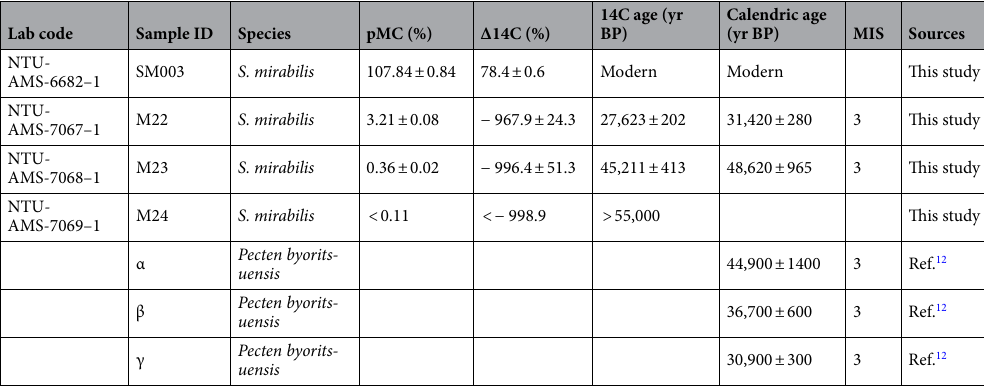
Table 1. Comparisons of 14 C dates based on modern (SM003) and fossil (M22-M24) sand dollars and fossil mollusks reported in Peng et al. 12 . MIS Marine Isotope Stages. Modern is younger than AD